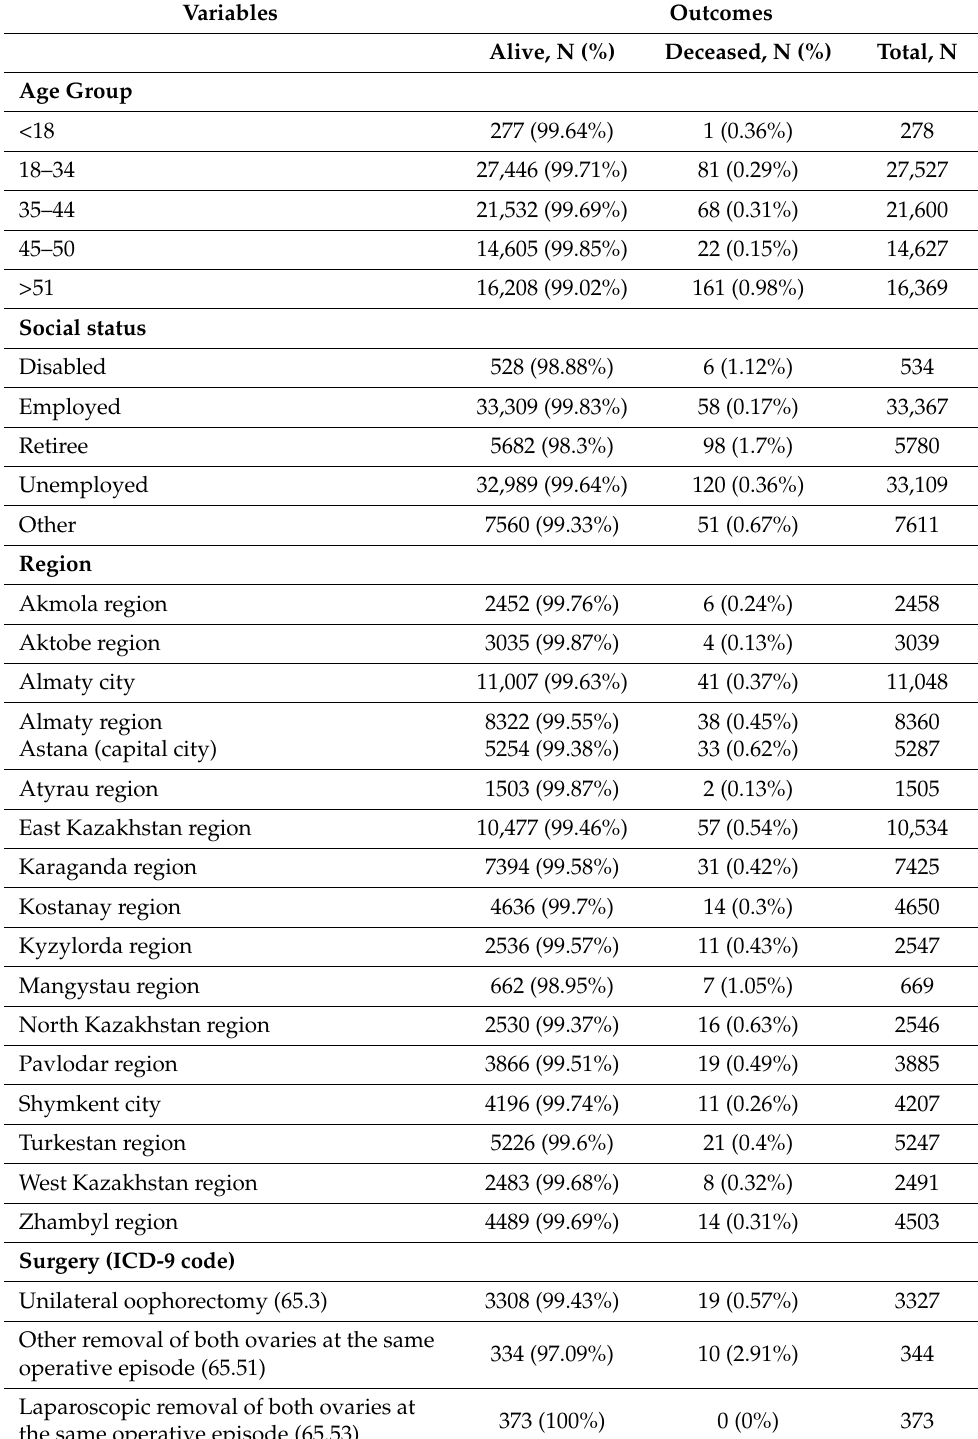
Table 3. Mortality rates among the study subjects, linked to the socio-demographic determinants, and descriptive